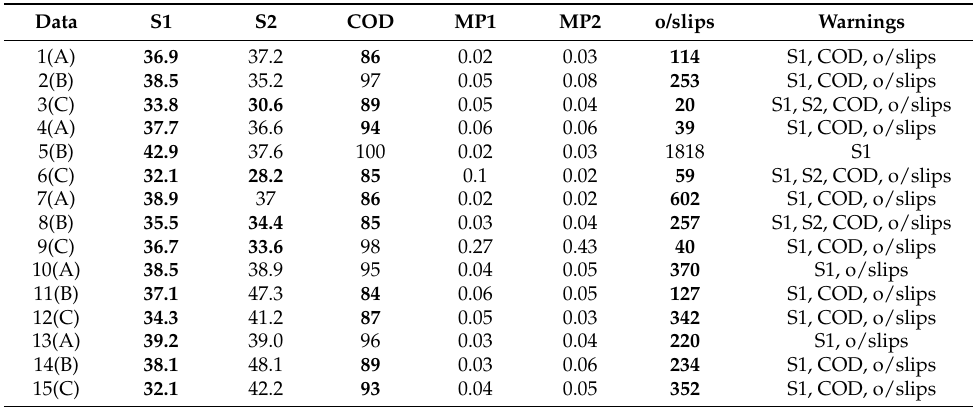
Figure 9. SNR time series of a data case. Table 2. Indicator statistics of SNR, completeness of observation data (COD), multipath effect (MP) and the O/SLPS.